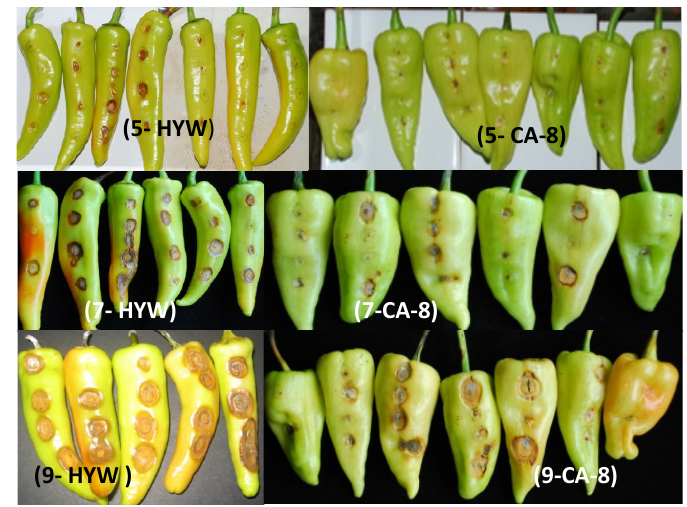
Figure 2: Pathogenicity of C. acutatum on chili peppers (cvs. CA-8 and HYW) 5, 7 and 9 DAI.